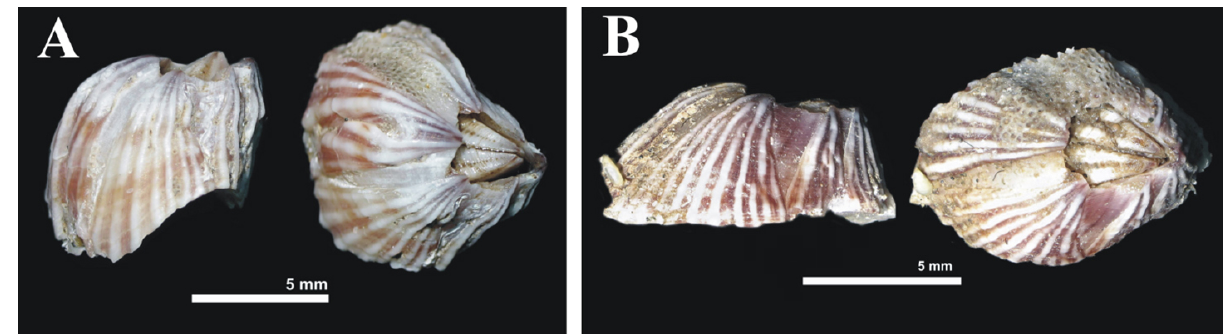
Figure 2. Large specimens of Balanus trigonus Darwin, 1854, collected on spiny lobsters. A. On the gastric area of an immature female of Panulirus gracilis Streets, 1871 (CL 91 mm). B. On the gastric area of one mature female of P. inflatus (Bouvier, 1895) (CL 70